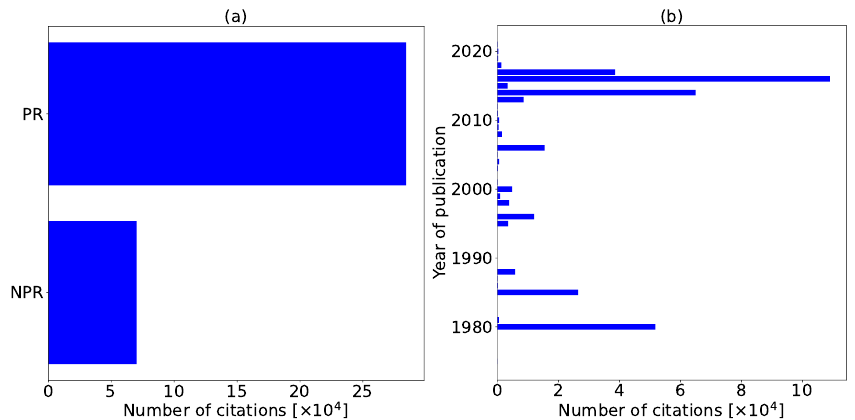
Figure 5. ( a ) Visualizes manuscript citations per review status showing NPR and PR manuscripts, and ( b ) shows relationships between the number of citations per each manuscript and year of publication. 3. RQN1: What Are the Negative Factors That Lead to the Occurrence of